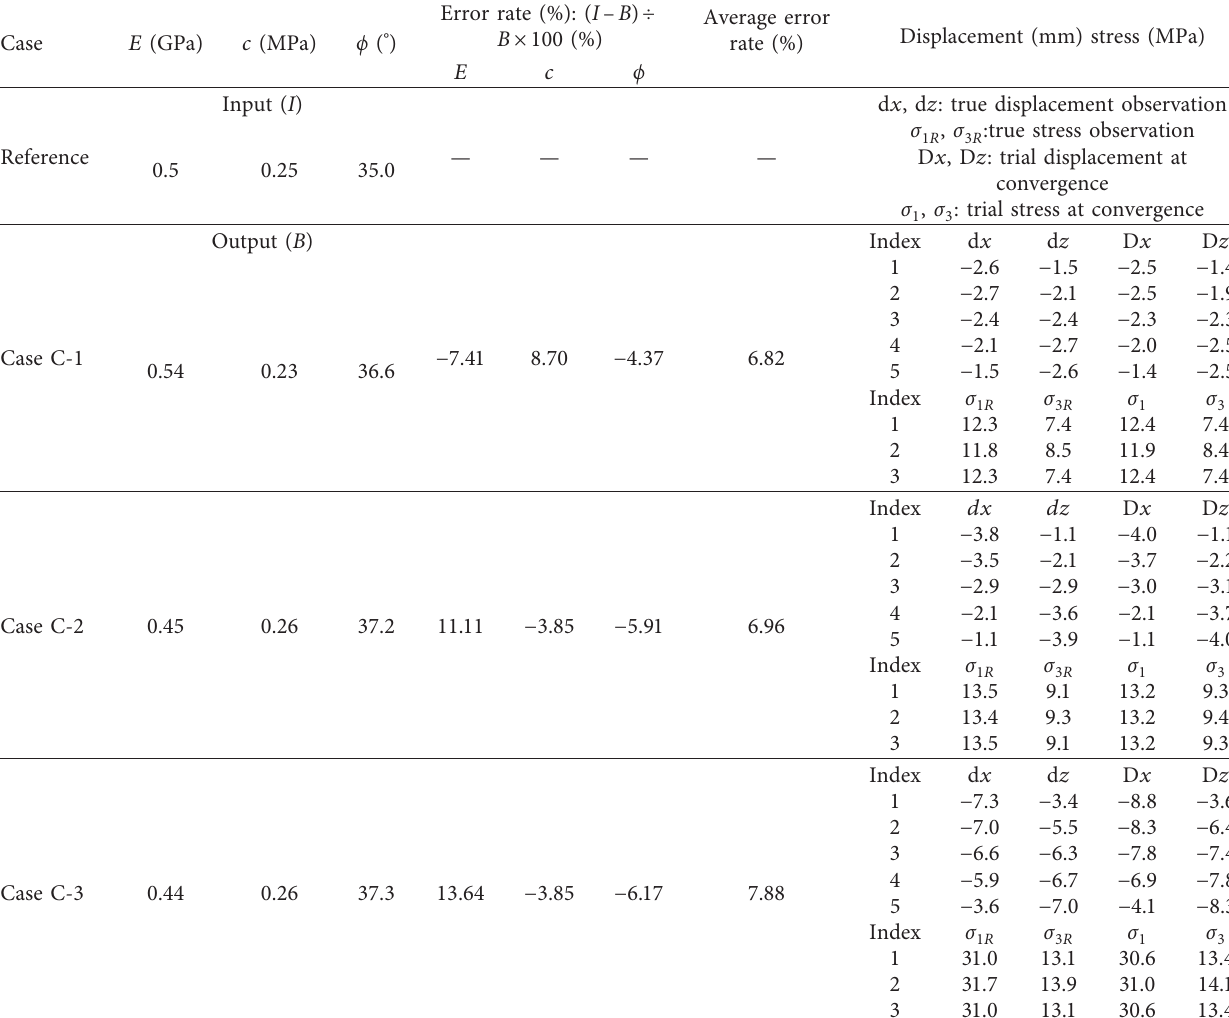
Table 6: Results of back analysis on a segment-lined tunnel using stress and